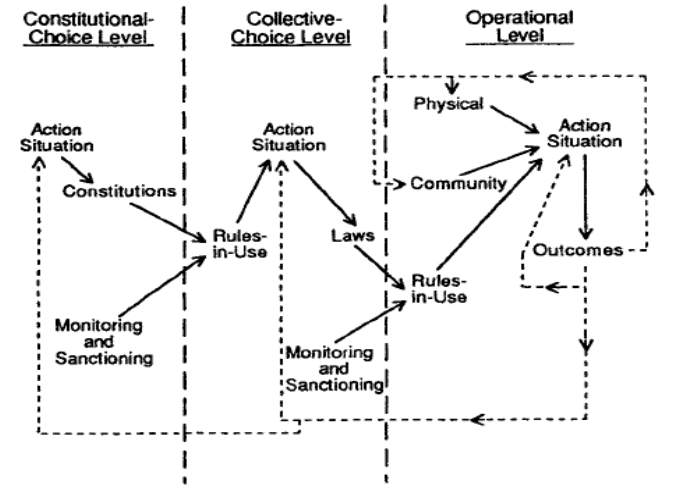
Fig. 4. Bloomington school’s IAD framework (Ostrom et al., 1994, p.